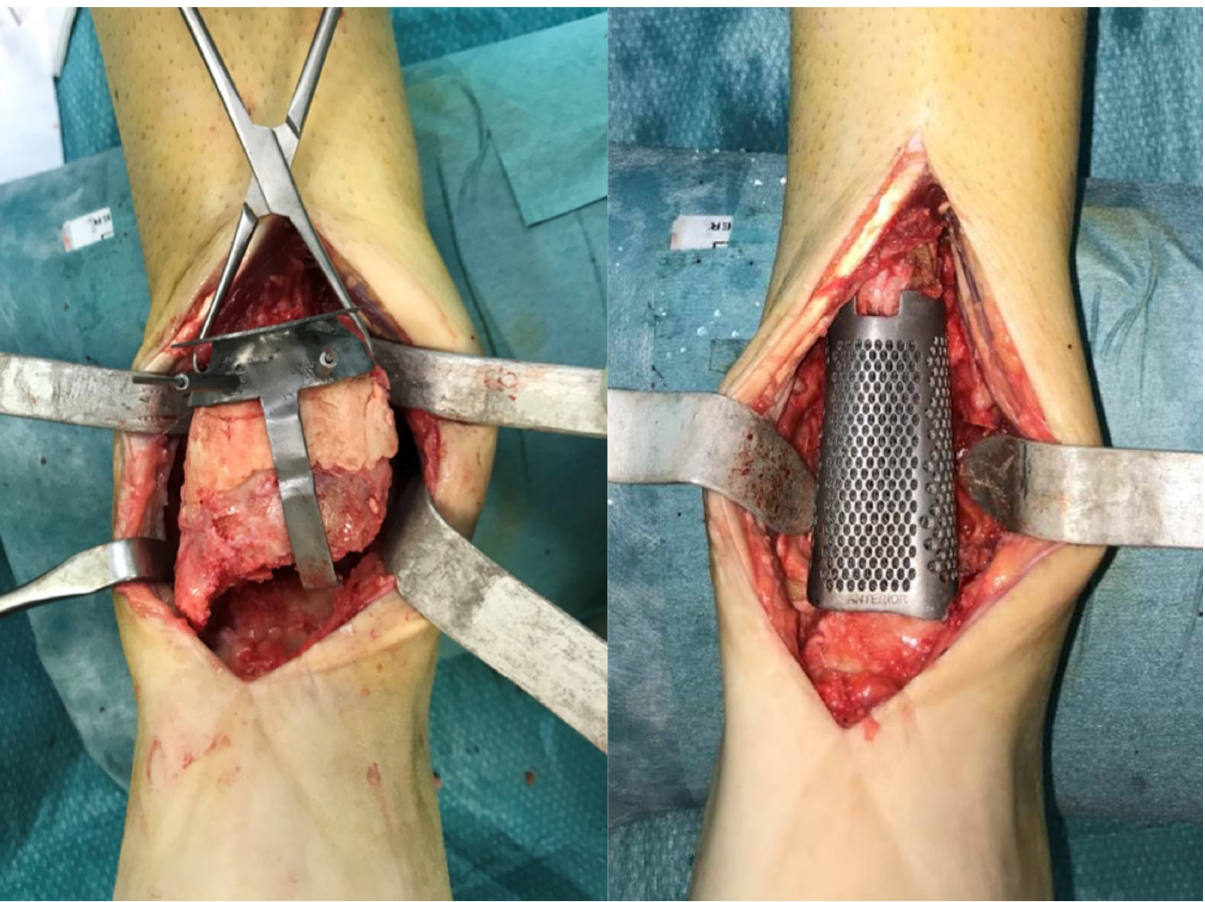
Figure 3. Intra-operative image. Guided resection using custom-made cutting guide ( left ) and implanted 3D-printed trabecular metal spacer ( right ).